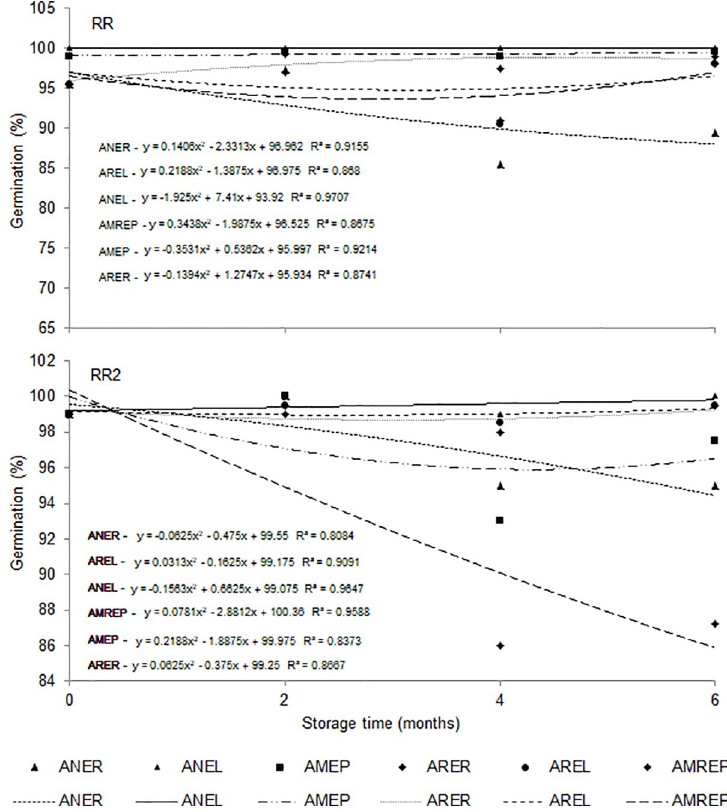
Fig 7. Germination (%) of soybean seeds of cultivar RR and RR2 according to different conditions and storage time. Ambient air + raffia packaging—ANER, ambient air + packaging laminate packaging—ANEL, modified atmosphere (-14 PSI) + polyethylene packaging—AMEP, refrigerated atmosphere (1 to 3˚C) + raffia packaging— ARER, refrigerated atmosphere (1 to 3˚C) + laminate packaging—AREL, modified atmosphere (-14 PSI) + polyethylene packaging + refrigerated (1 to